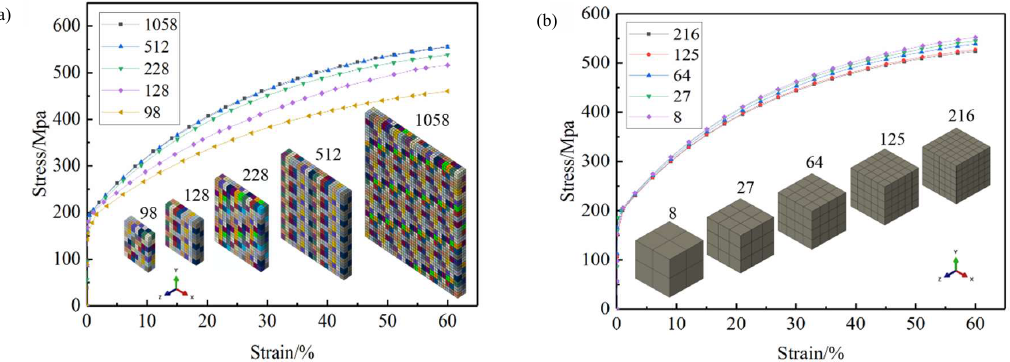
Figure 3. Effectofgrainnumber( a )andunitnumber( b